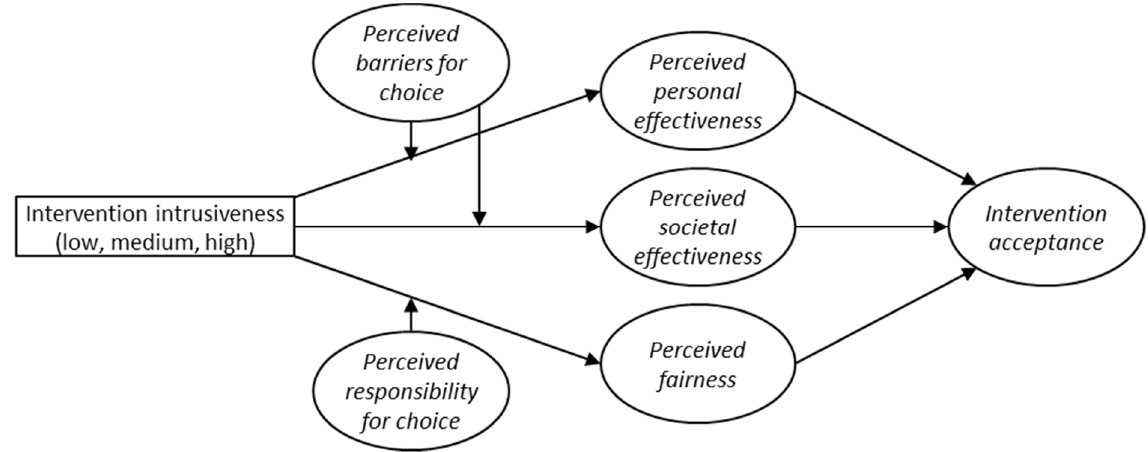
Figure 1. Overview of the present study’s conceptual framework.